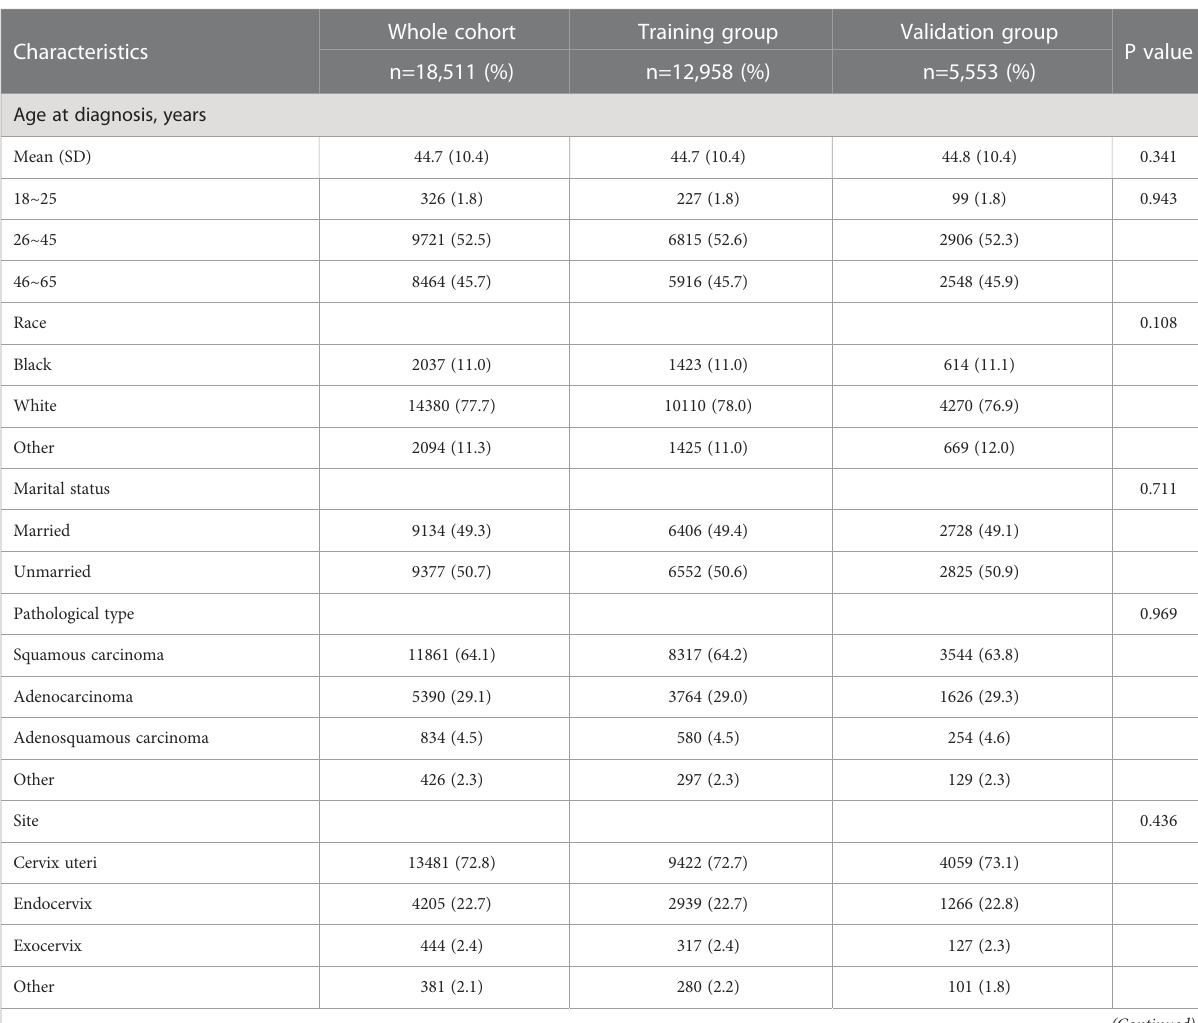
TABLE 1 Patient clinicopathologic characteristics in cervical